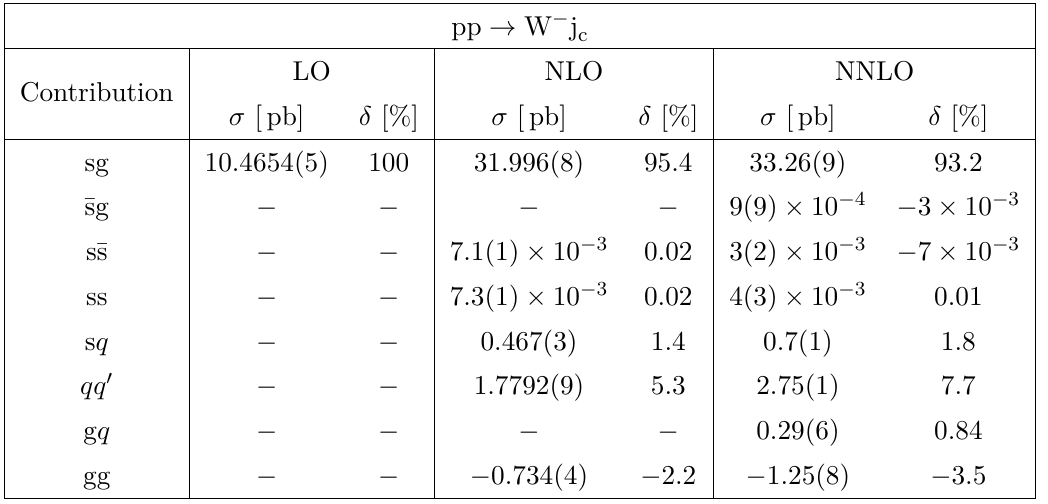
Table 6. As in table 5 but for pp → µ − ν µ j